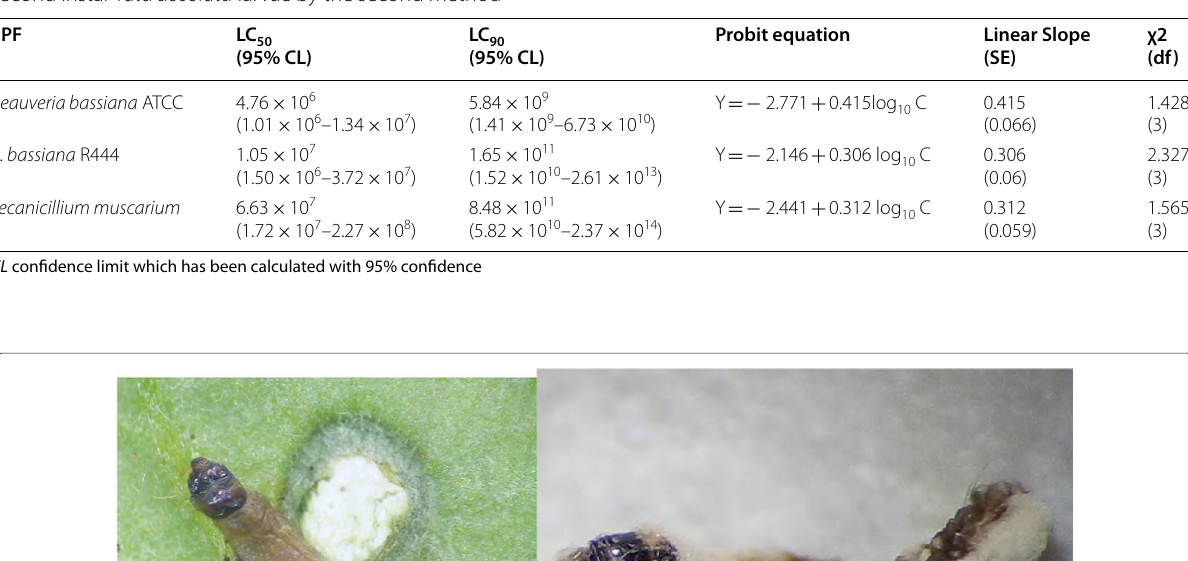
Table 4 Probit analysis at 7 days after treatment with Beauveria bassiana ATCC, B. bassiana R444 and Lecanicillium muscarium against second instar Tuta absoluta larvae by the second method